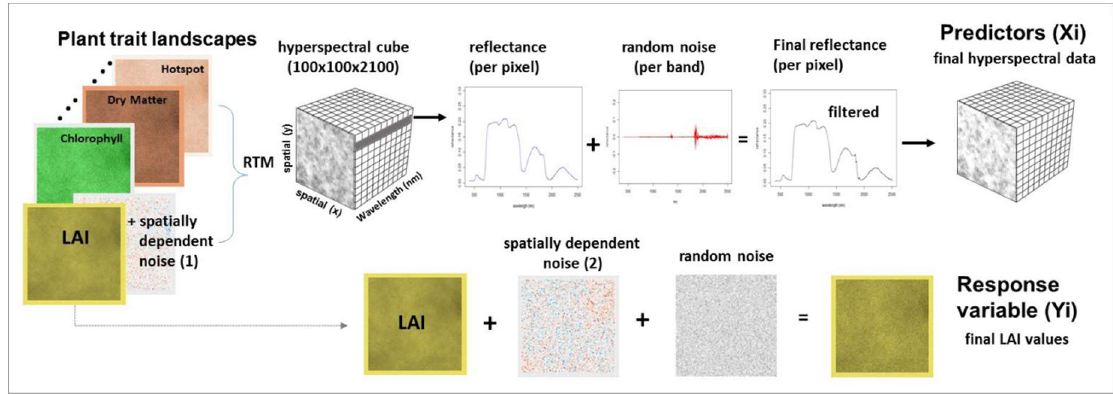
Figure 2. Spectral simulation and process to generate predictors and response variable for